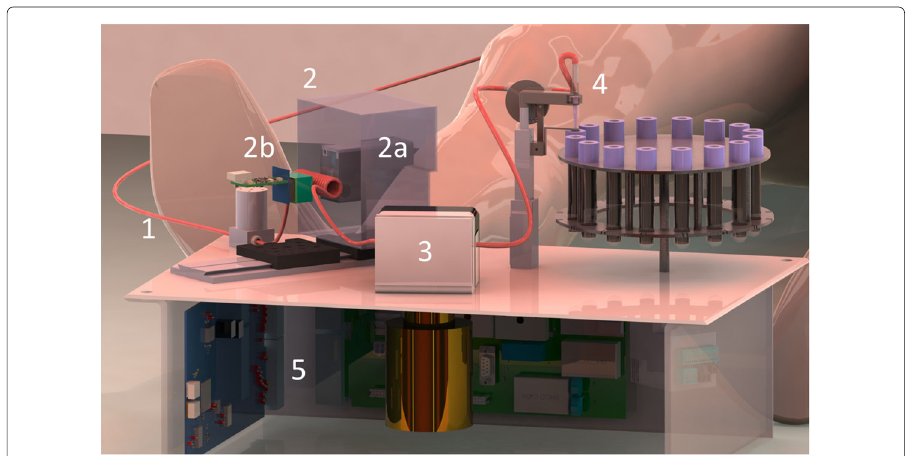
Fig. 1 In this 3D rendering, the catheter 1 passes close to the gamma detection modules ( 2a , 2b shown without shielding) then through the peristaltic pump 3 . A Y-connector allows to control the flow towards a waste container or a carousel holding evacuated tubes 4 . Acquisition boards are also shown 5 . For this work, a configuration with a single detector module 2a was evaluated, shown here with its transparent-rendered shielding 2a . The actual tungsten shielding is shown in Fig.